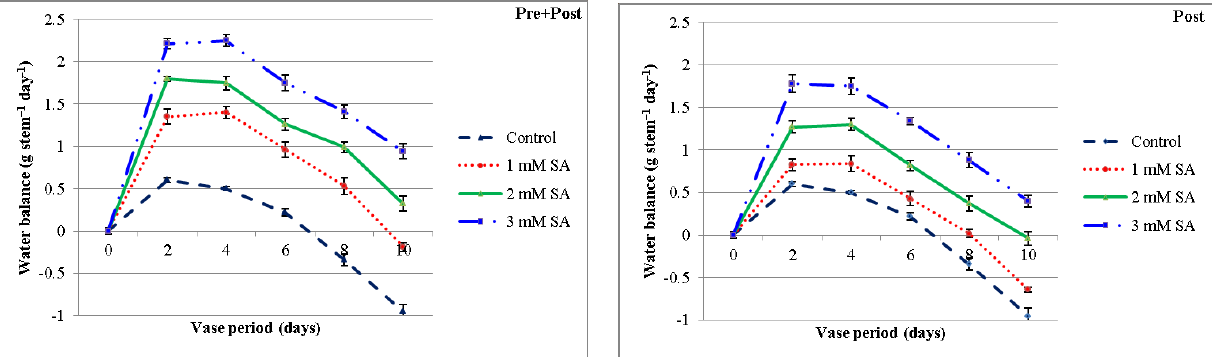
Fig. 4. Effect of pre + post-harvest and post-harvest applications of different concentrations of salicylic acid on water balance (g stem -1 day -1 ) of cut alstroemeria flowers during vase period. The results represent the means of 12 cut flowers in 4 replicates ± stan- dard